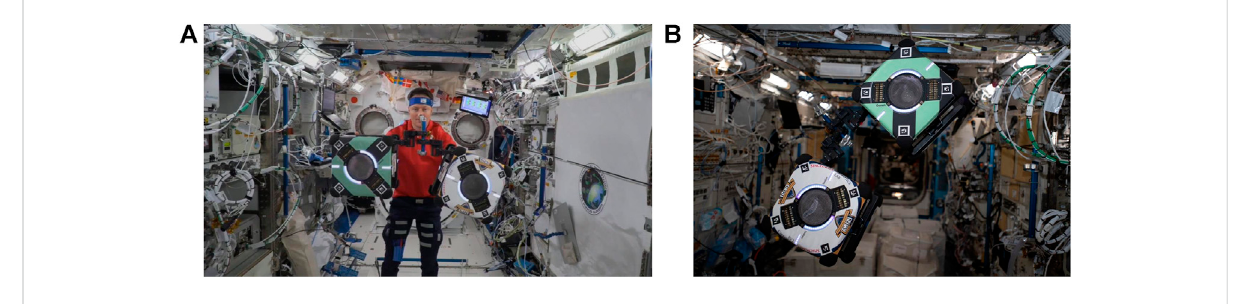
Frontiers in Robotics and